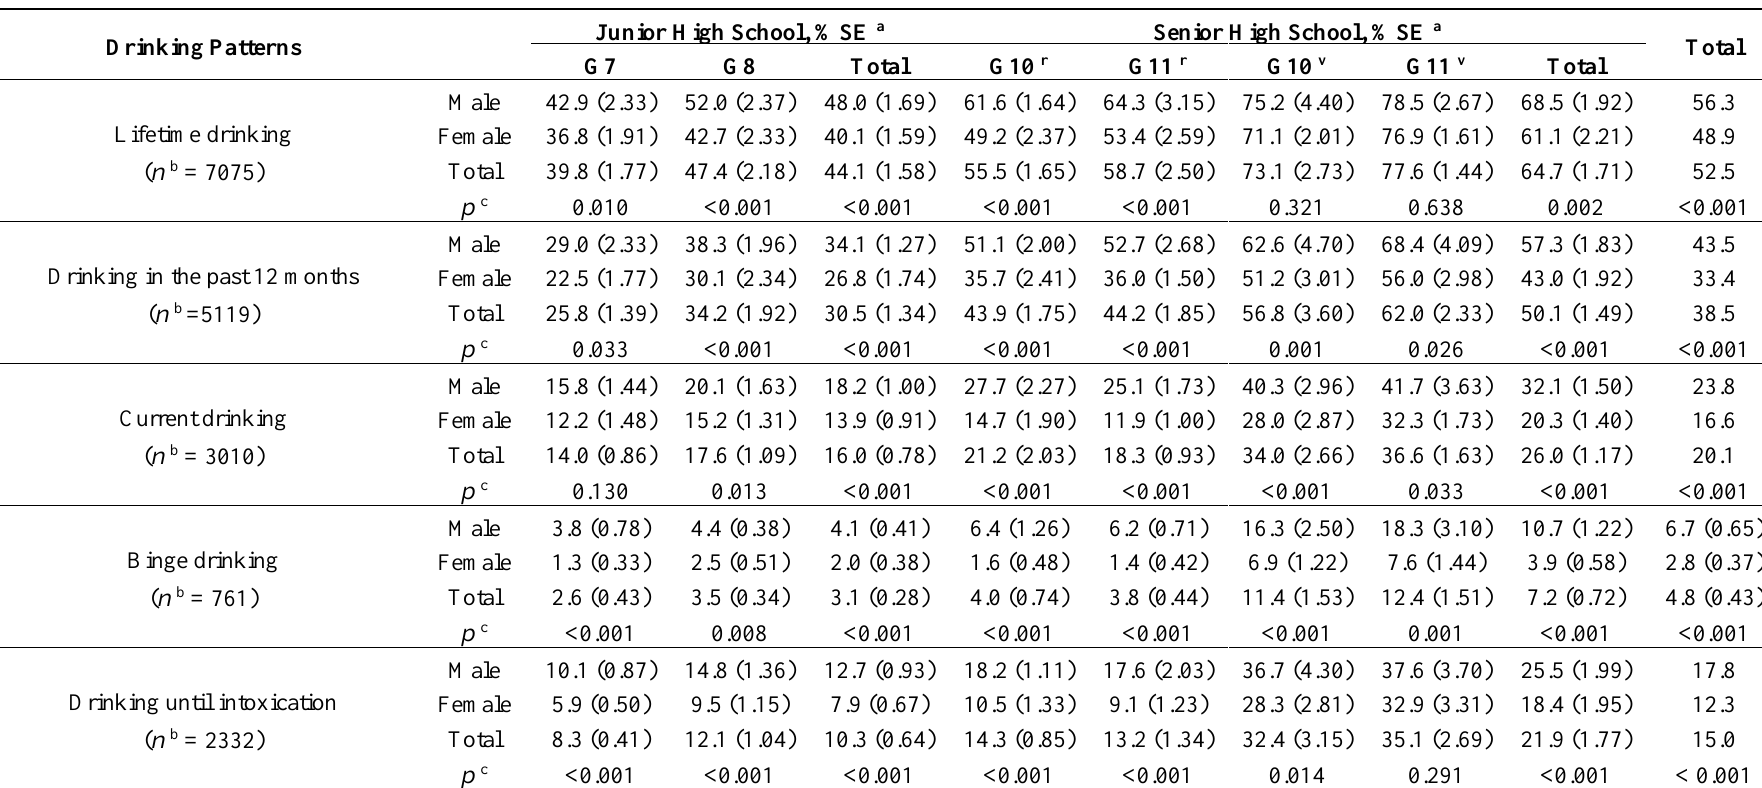
Table 2. Prevalence of alcohol consumption by school and